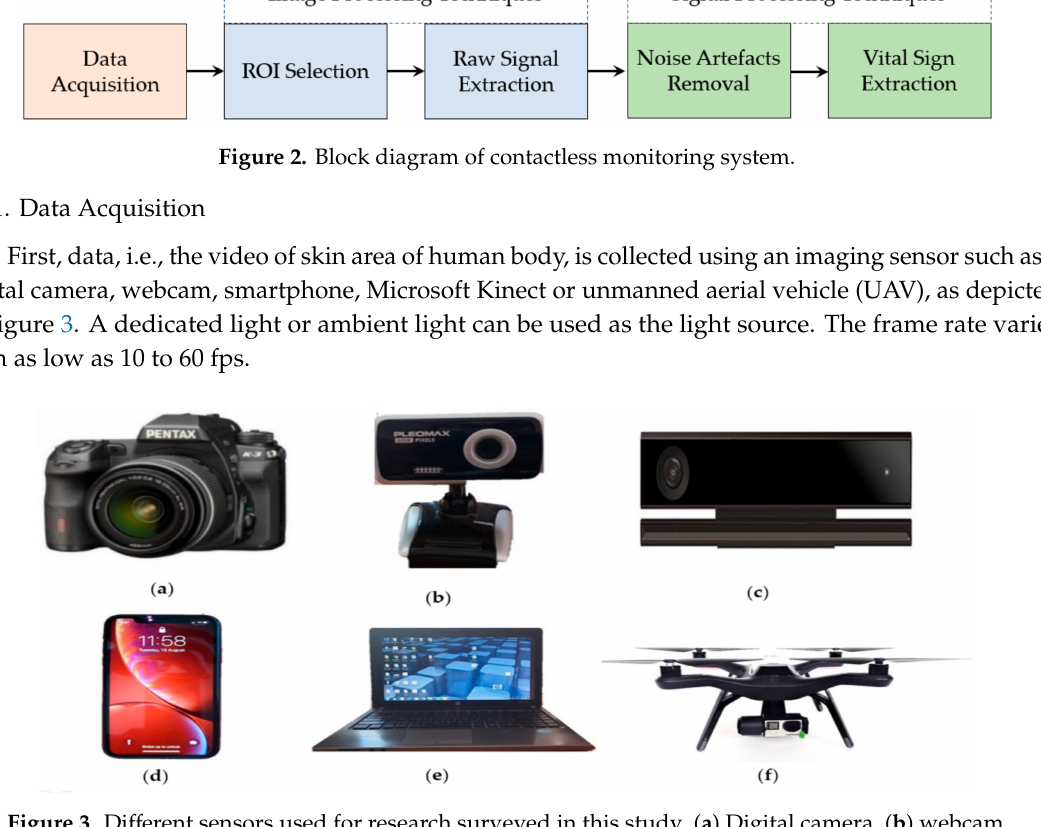
Figure 3. Di ff erent sensors used for research surveyed in this study. ( a ) Digital camera, ( b ) webcam, ( c ) Microsoft Kinect, ( d ) smart phone, ( e ) laptop, ( f ) unmanned aerial vehicle